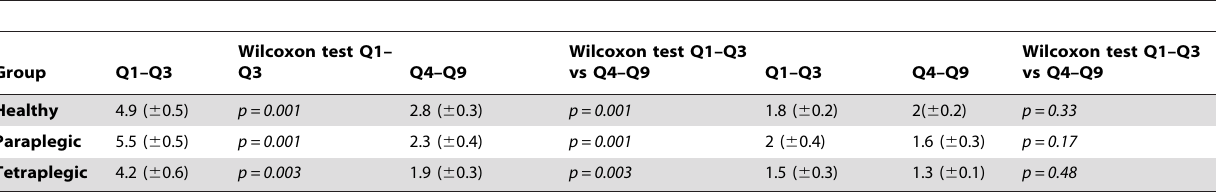
Table 3. Mean score and standard error for each group in the illusion relevant (average of Q1–Q3) versus the illusion-irrelevant (average of Q4–Q9) items of the rubber hand illusion questionnaire after synchronous and asynchronous stimulation.